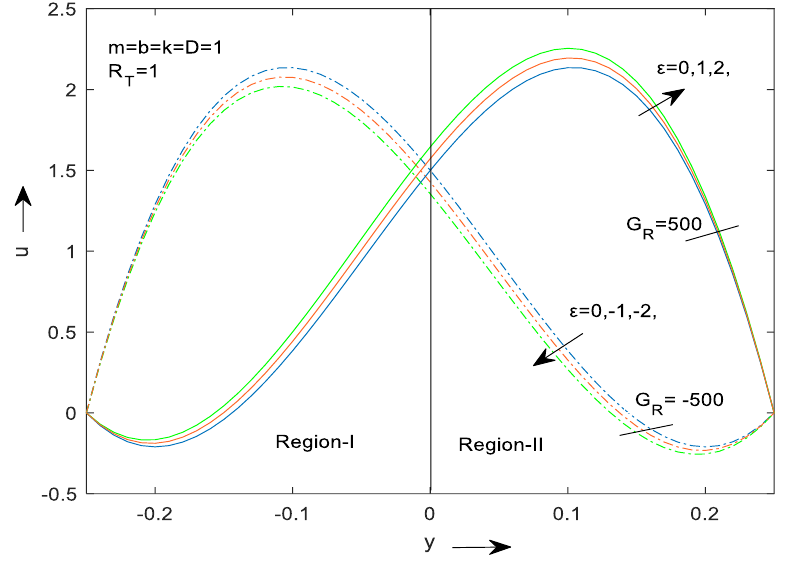
Fig. 4a. Velocity profile for different values of ɛ .